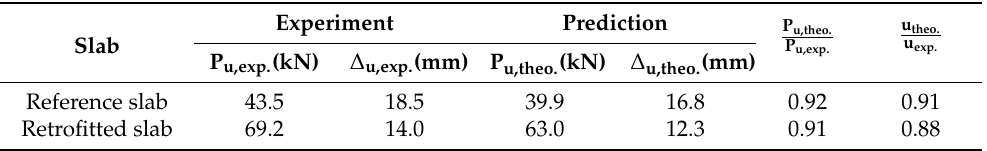
Figure 10. The cracks at the mid ‐ span of the slab: ( a ) front view; ( b ) bottom view. Table 7. Predictions of slabs’ loading ‐ carrying capacity and corresponding mid ‐ span deflection compared with experimental results.